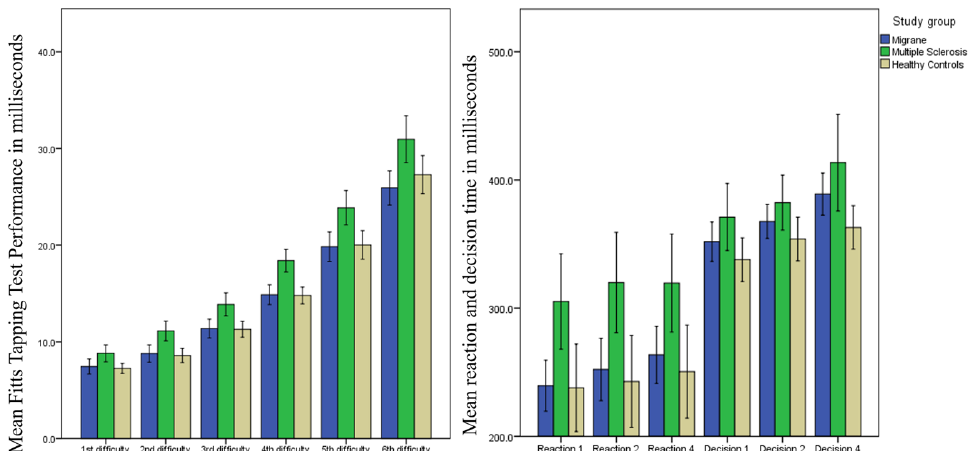
Figure 4. Box plot illustrating psychomotor performance between the three study groups. Legend: FTT—Fitts’ Tapping Task. The FTT performance measured at each difficulty level is shown in the first panel (left), whereas the reaction and decision times are shown in the second panel (right). Data are shown as the mean and error bars depict two standard errors.